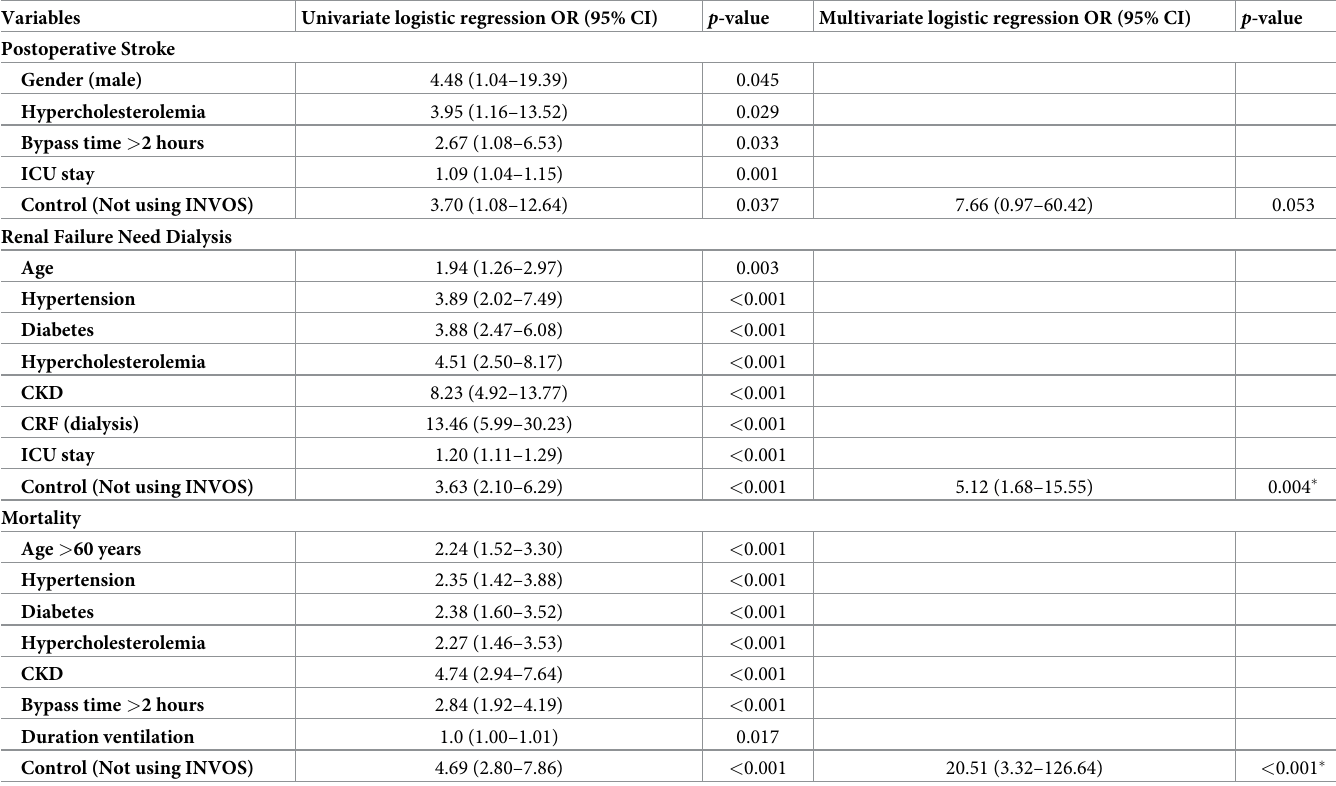
Table 2. Predictors for significant complications in case and control